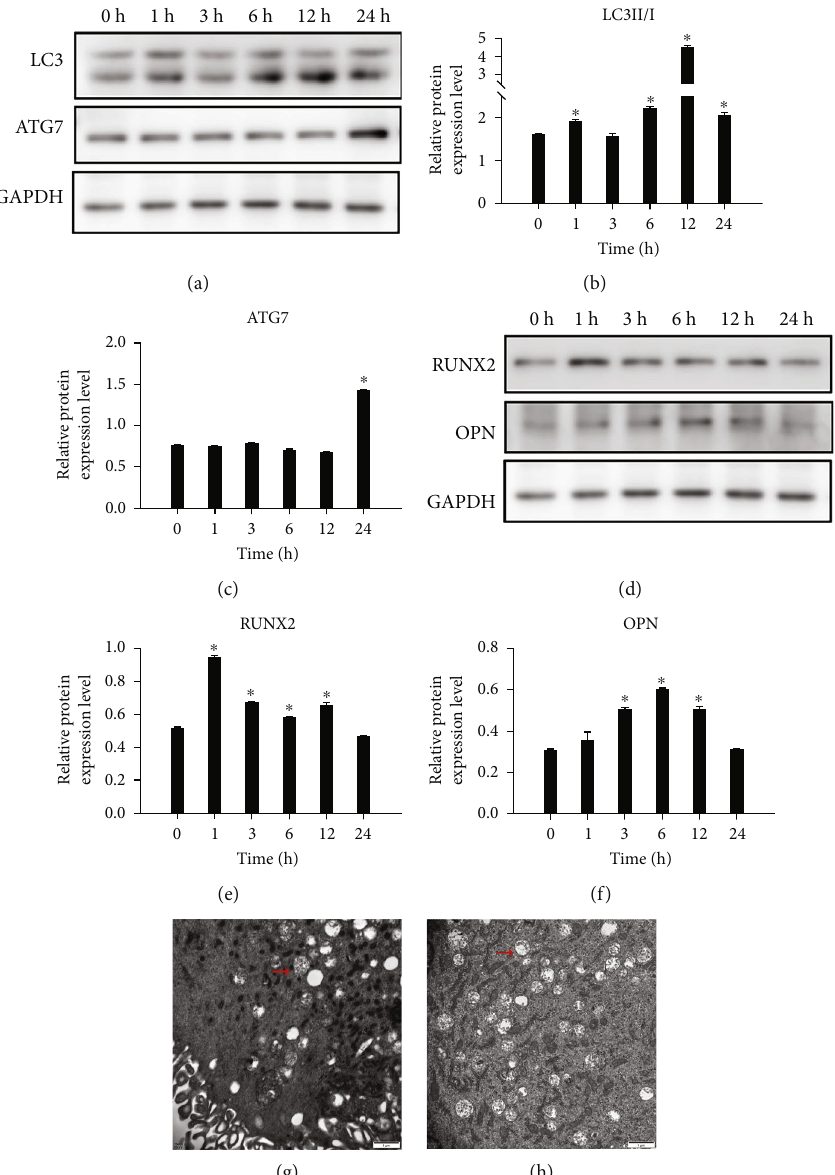
Figure 3: Changes in osteogenic and autophagy levels under mechanical stretch. (a – c) LC3- and ATG7-relative protein expression levels assessed by western blotting at 0, 1, 3, 6, 12, and 24h. (d – f) RUNX2- and OPN-relative protein expression levels assessed by western blotting at 0, 1, 3, 6, 12, and 24h. (g, h) Autophagy activation was monitored by transmission electron microscopy, indicated by red arrows. ∗ P < 0 : 05